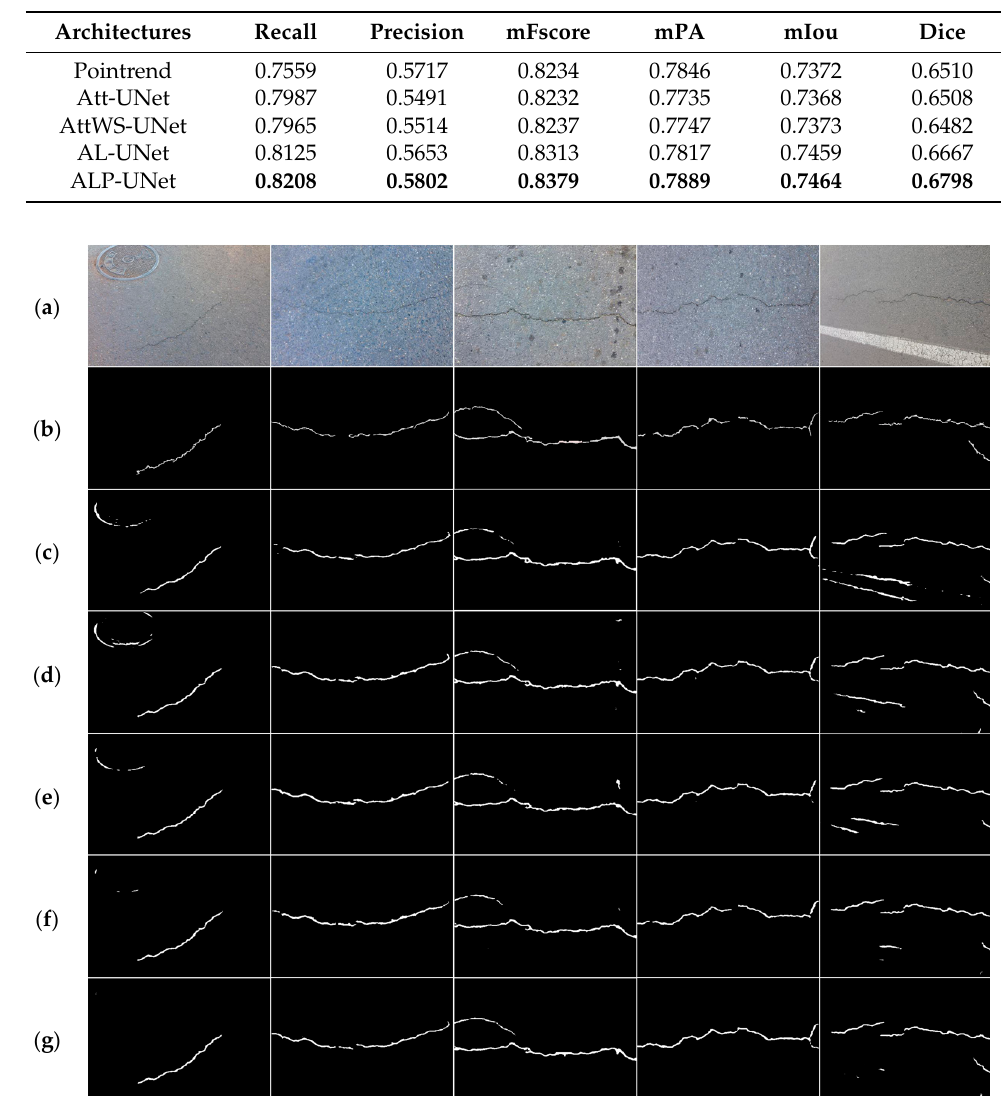
Table 2. Comparison results of ablation experiments on different modules.